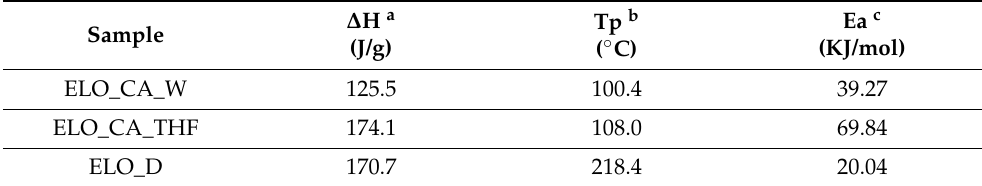
Table 2. DSC and GF results for ELO-based